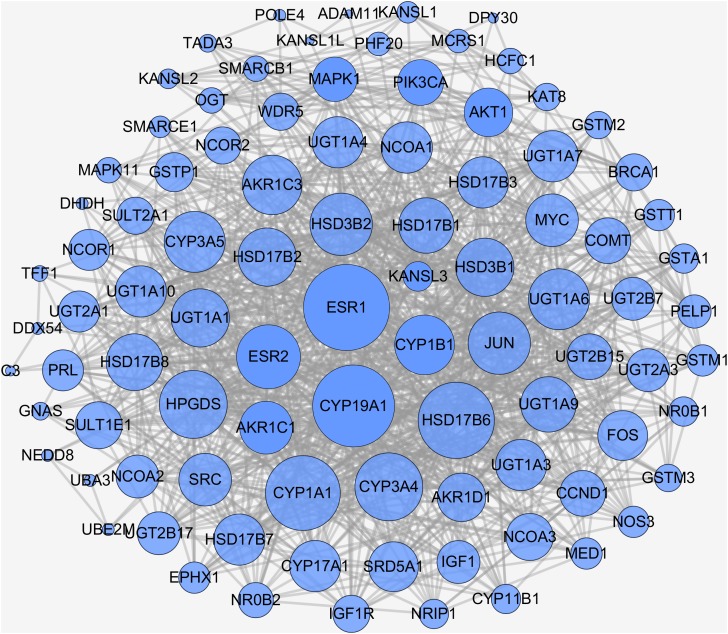
PPI network of naringenin-mediated proteins.The nodes indicate proteins and the edges indicate interaction between proteins. High node degree value was represented by big size and low node degree value was represented by small size.